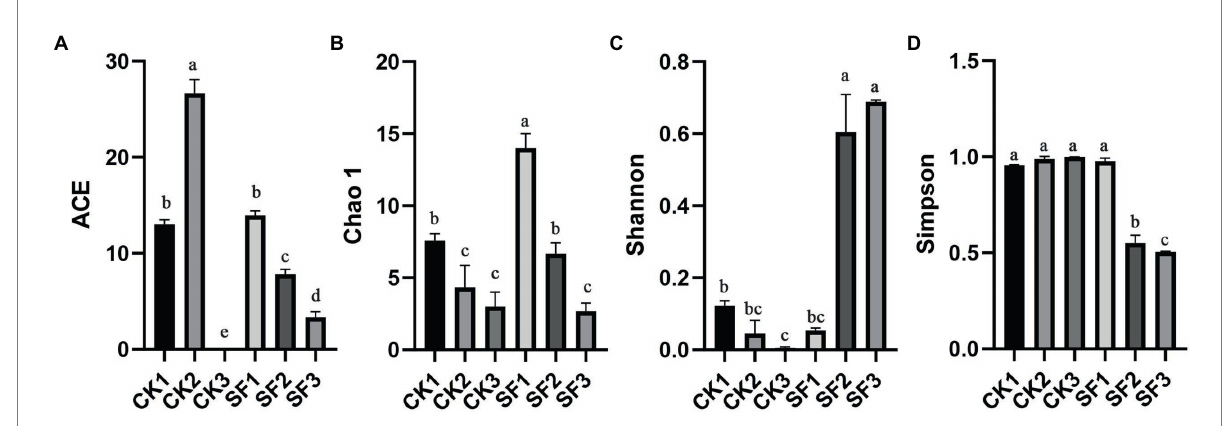
FIGURE 1 Comparative analysis of α -diversity indexes of fungal flora in BH at different fermentation